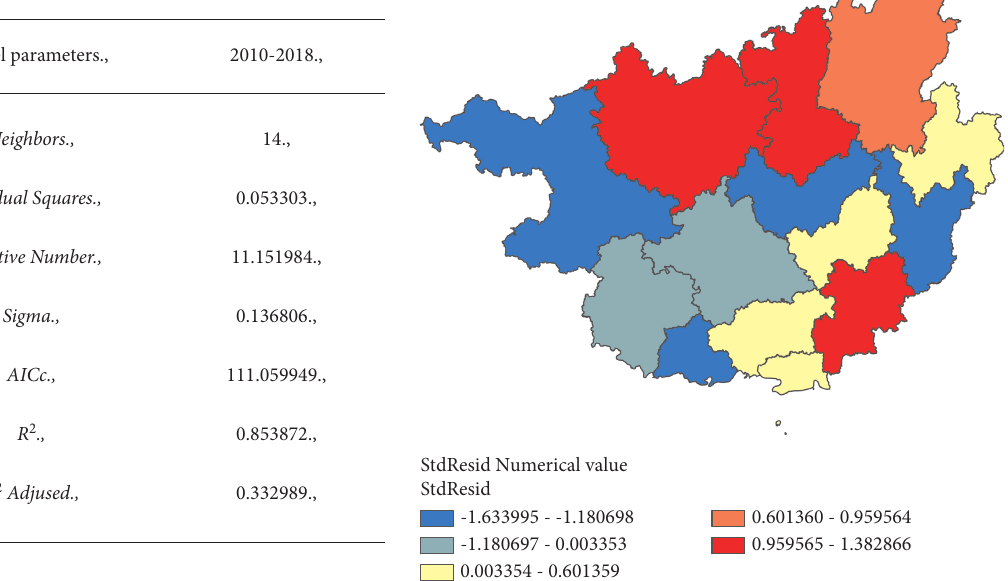
Figure 11: Results diagram of GWR